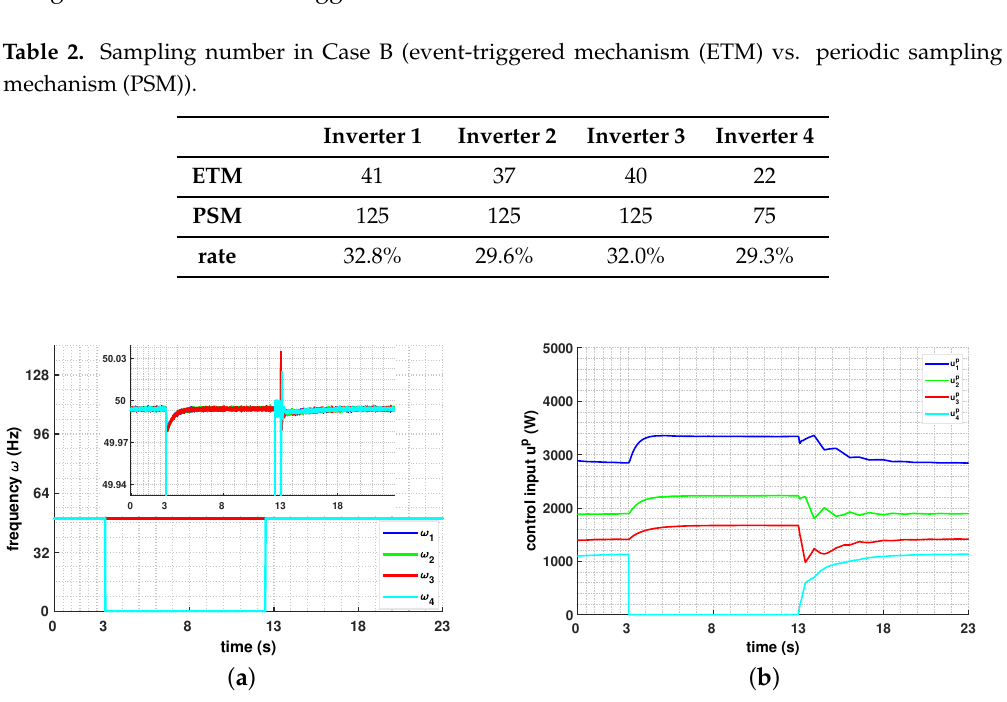
Figure 10. Responses of frequency and active power control input for event-triggered mechanism in Case B. ( a ): Responses of frequency; ( b ): Responses of active power control input.